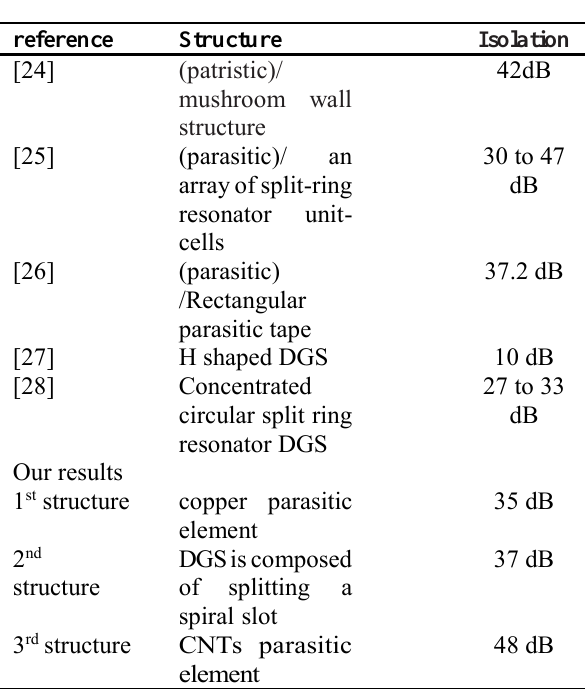
Table 1: Summary of some previous research results as well as our results